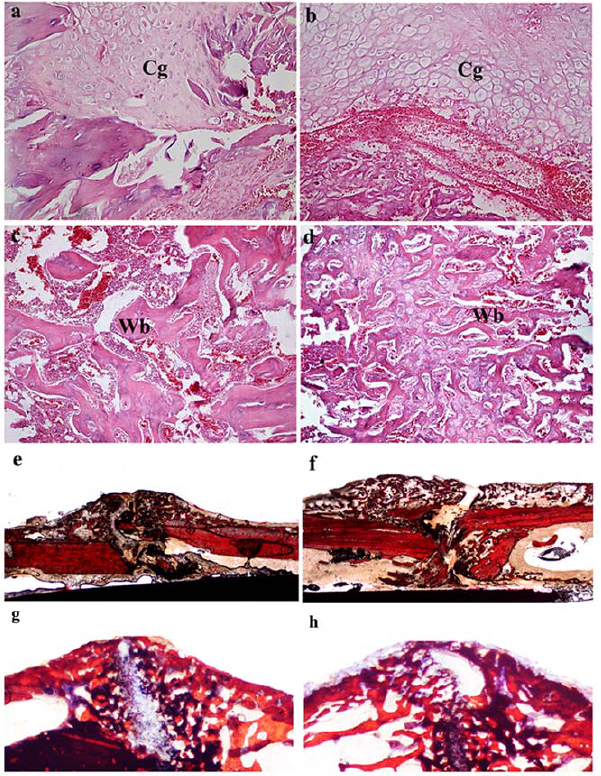
Figure 2. Histological presentations of OVX + vehicle (a, c, e, g) and OVX + perindopril (b, d, f, h) callus zones at 2 (a, b, e, f) and 4 (c, d, g, h) weeks post-fracture (n=6 per group). Original magnifications: e, f: 6 10; g, h: 6 20; c, d: 6 100; a, b: 6 200. Cg, cartilage callus; Wb, woven bone.